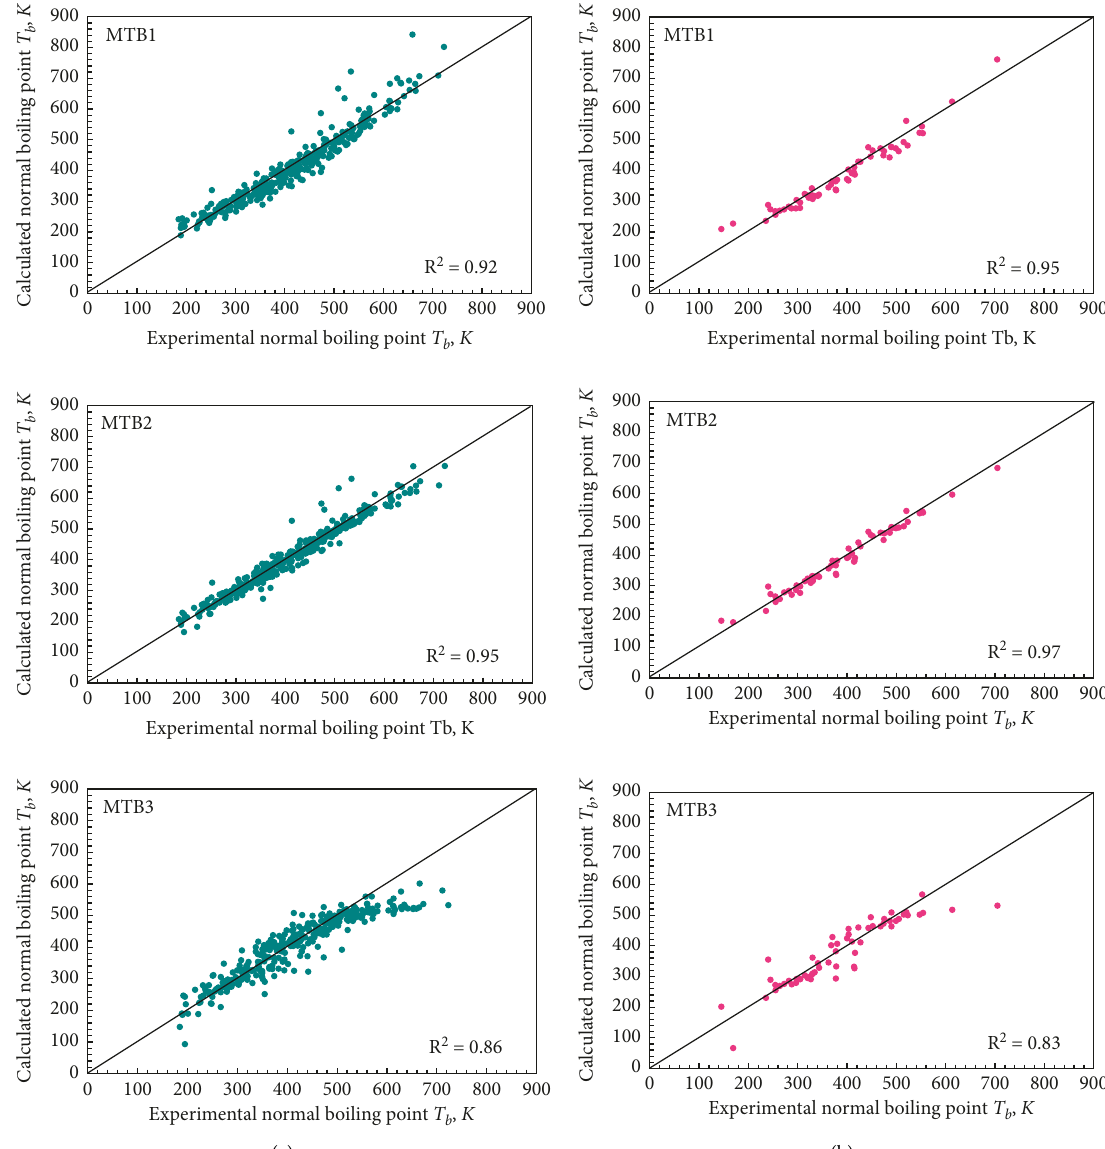
Figure 1: Results of the calculation of the normal boiling point of pure compounds using different first-order GCMs. (a) Correlation and (b)